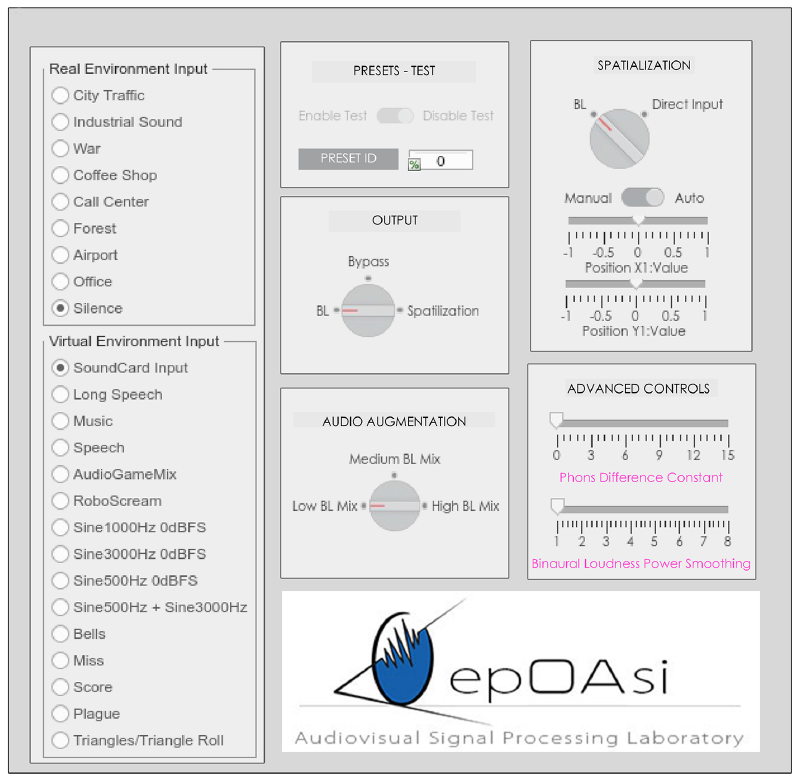
Figure 12. Adaptive ARA mix